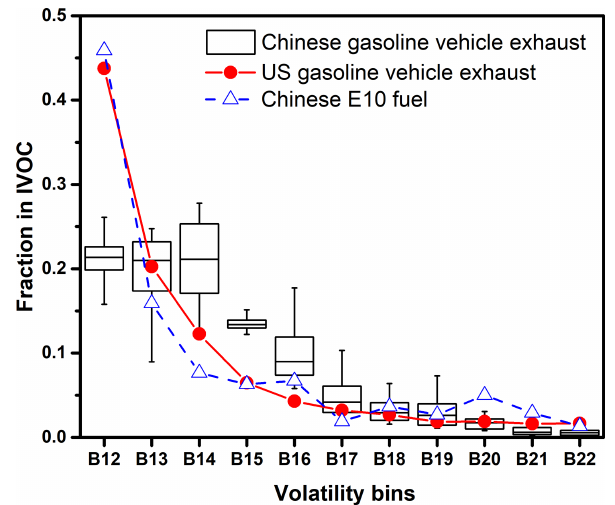
Figure 3. Comparison of IVOC volatility distributions of Chinese gasoline vehicle exhaust, US gasoline vehicle exhaust and Chinese E10 fuel. The boxplot represents the Chinese gasoline vehicle ex- haust. The boxes represent the 25th and 75th percentiles with the centerline being the median. The whiskers are the 10th and 90th percentiles. Red solid circles represent IVOC fractions of US ve- hicle exhaust (Zhao et al., 2016). Blue hollow triangles represent the IVOC volatility distribution of Chinese E10 fuel. All the studies performed in the US used commercial US gasoline as fuel, which contained 10% v/v ethanol, i.e., E10 fuel. Therefore, we compare the Chinese E10 with US fuel to get a consistent comparison. Also, we should note that Zhao et al. (2016) and Lu et al. (2018) found that for a consistent distribution of US fuel and exhaust, as in this figure, the US gasoline vehicle exhaust can represent the volatility distribution of its unburned fuel distribution as